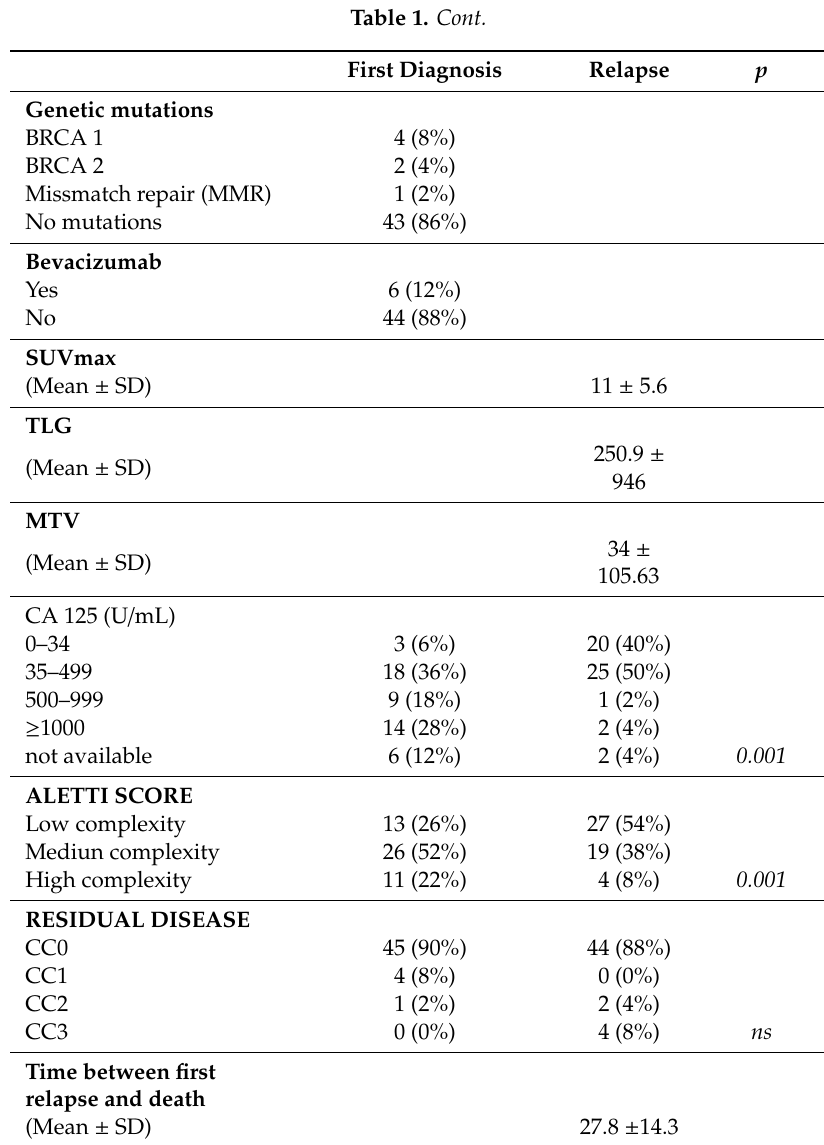
Legend: FIGO stage: International Federation of Gynecology and Obstetics, SUVmax: maximum standardized uptake values, MTV: metabolic tumor volume, TGL: total lesion glycolysis, SD: standard